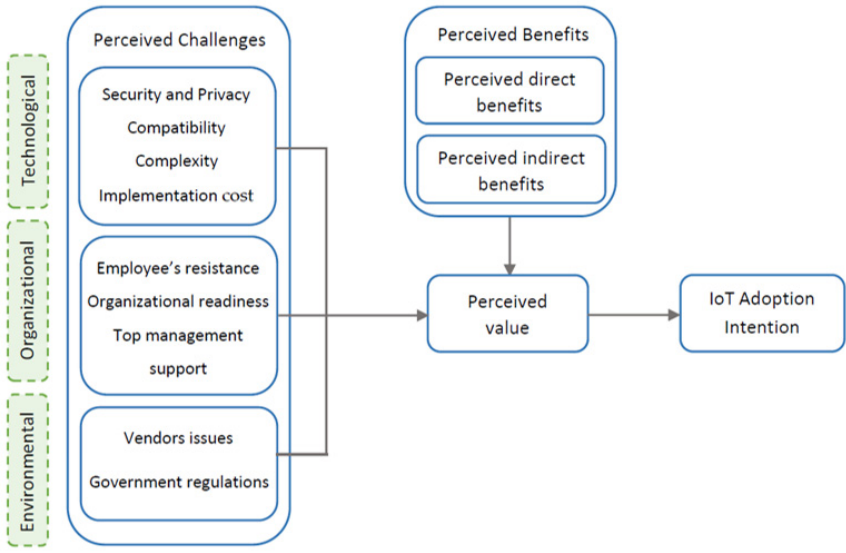
Figure 3. The conceptual model for IoT adoption in the MS.